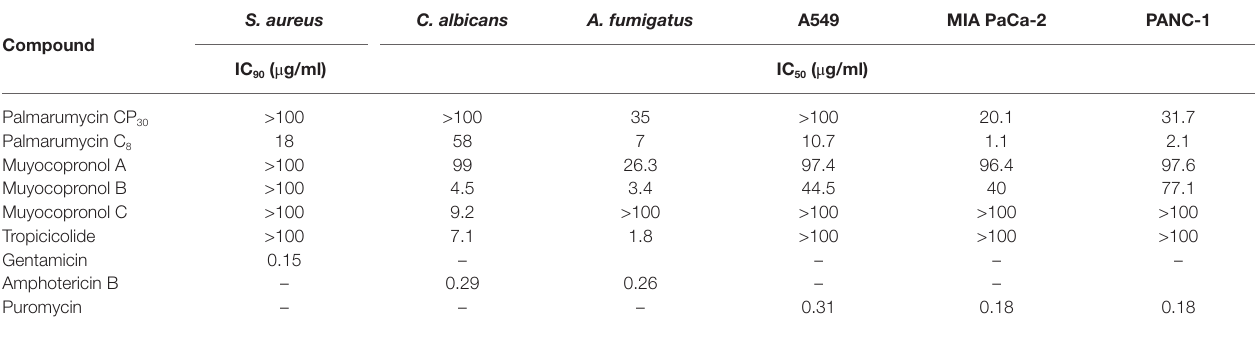
TABLE 5 | A comparison of the bioactivity of the six isolated compounds with the reference standard compounds used in the study.